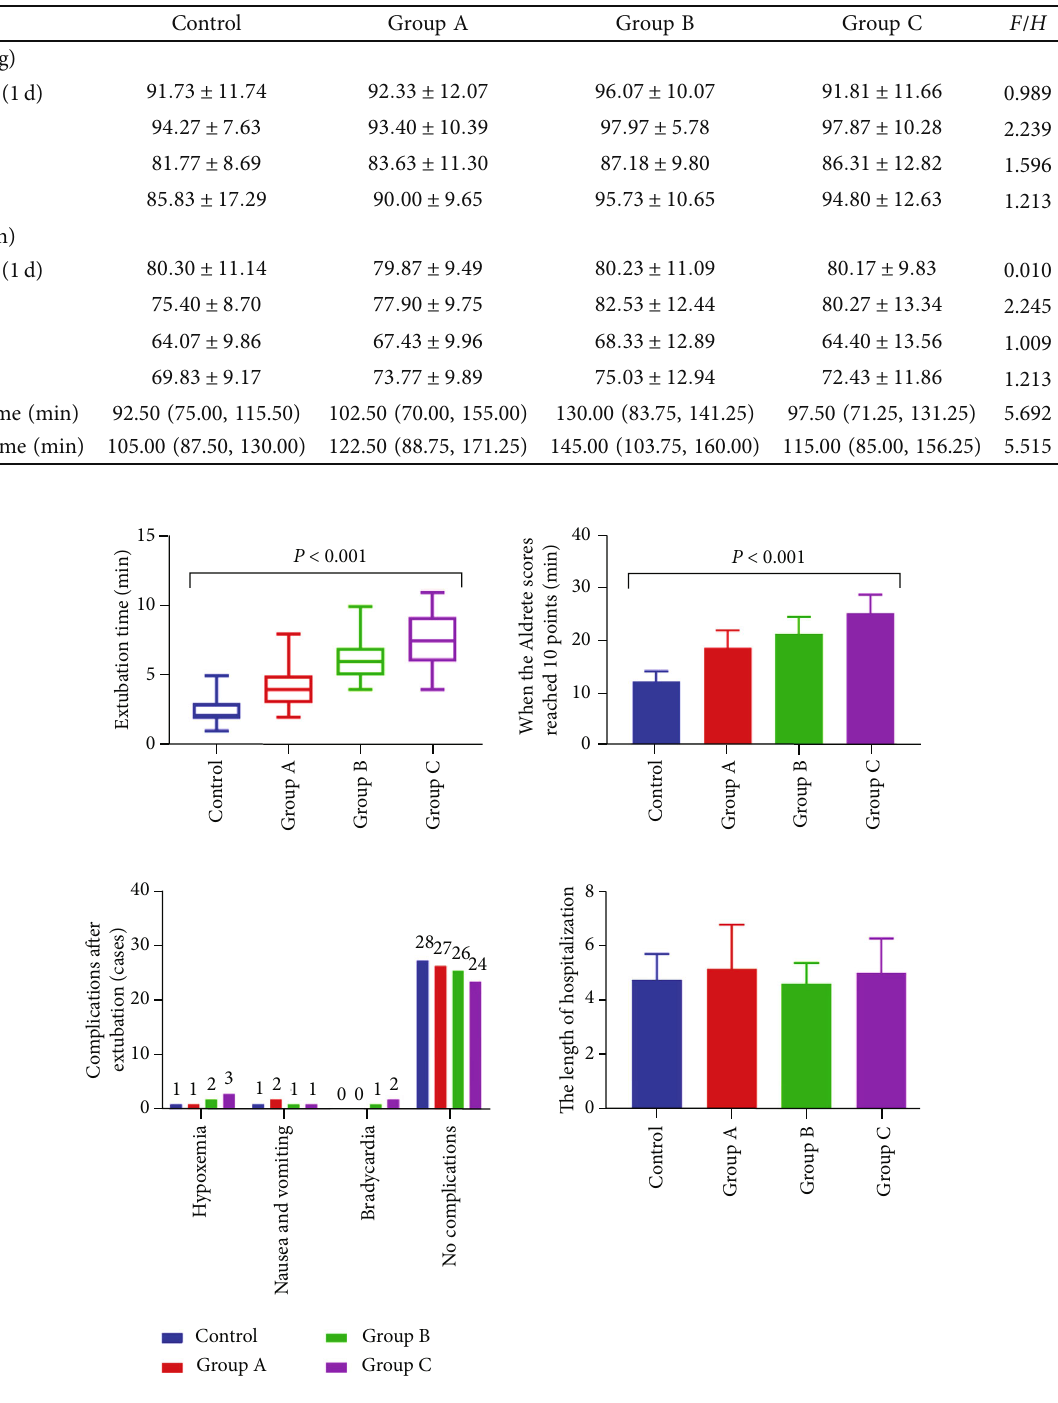
Figure 1: Comparison of the postoperative recovery quality among the four groups ( n = 30